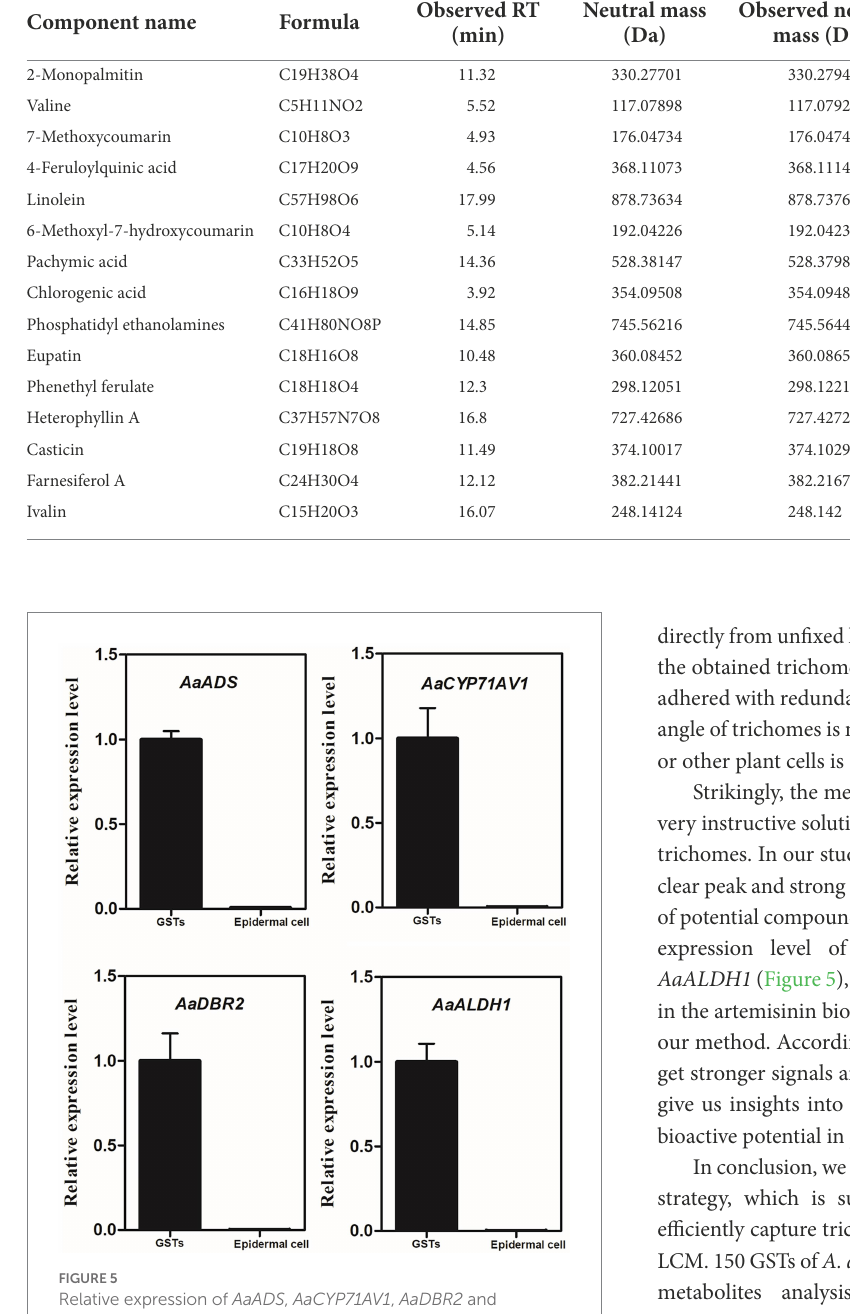
TABLE 1 The information of 15 potential compounds in GSTs based on UHPLC-Q-TOF with the database available in the UNIFI system.